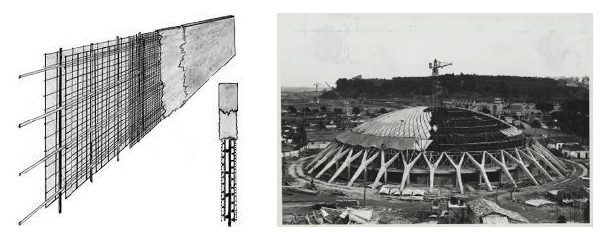
FigURe 8 | From the left: example of “ferrocement” wall. Nervi’s Palazzetto deillo Sport under construction, Rome (1954–1957) (courtesy of Fondazione MAXXI, Pieri Luigi Nervi